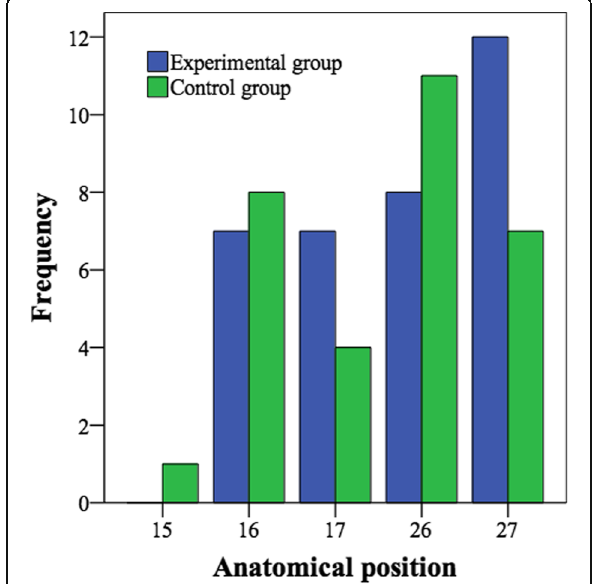
Fig. 1 Anatomical location of the control and Ca 2+ -modified dental